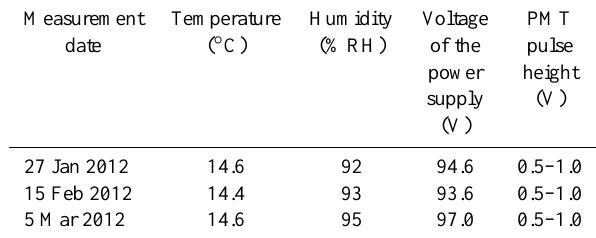
Table 1. Altitudes, depths, and measurement depths of the bore holes.